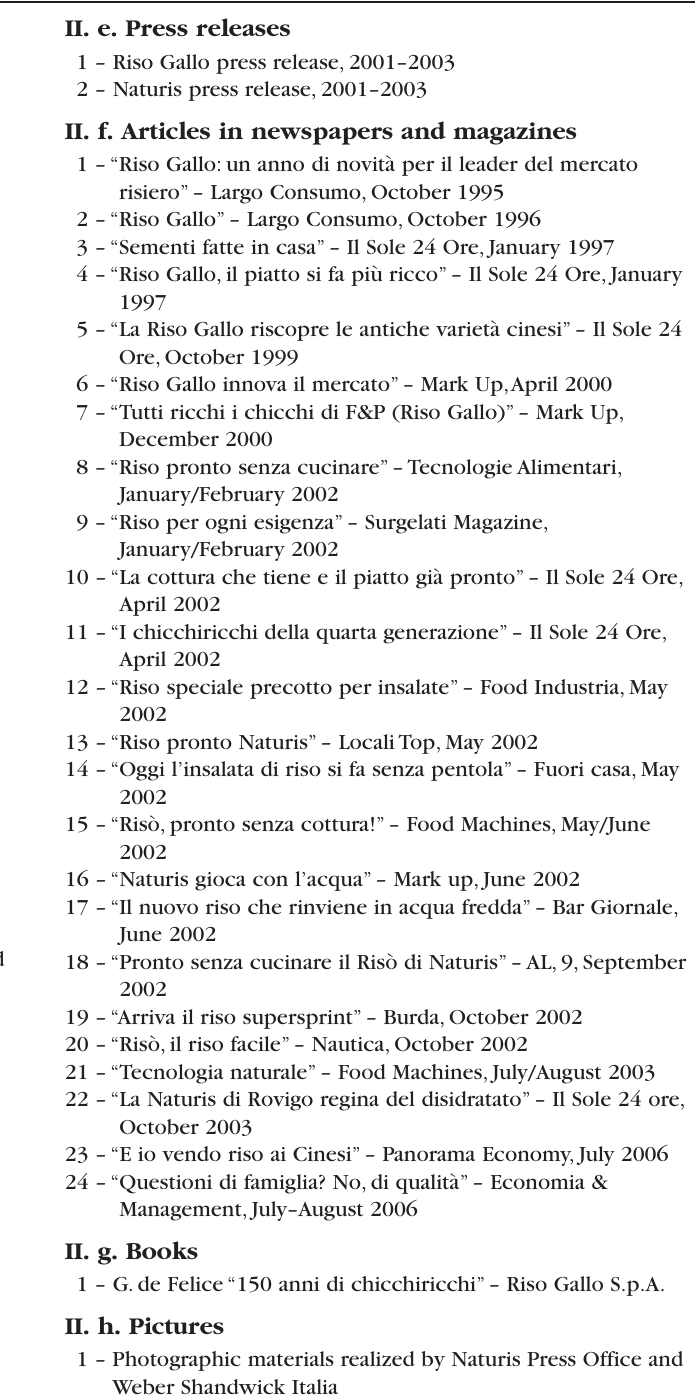
Table 1. Case Study Data